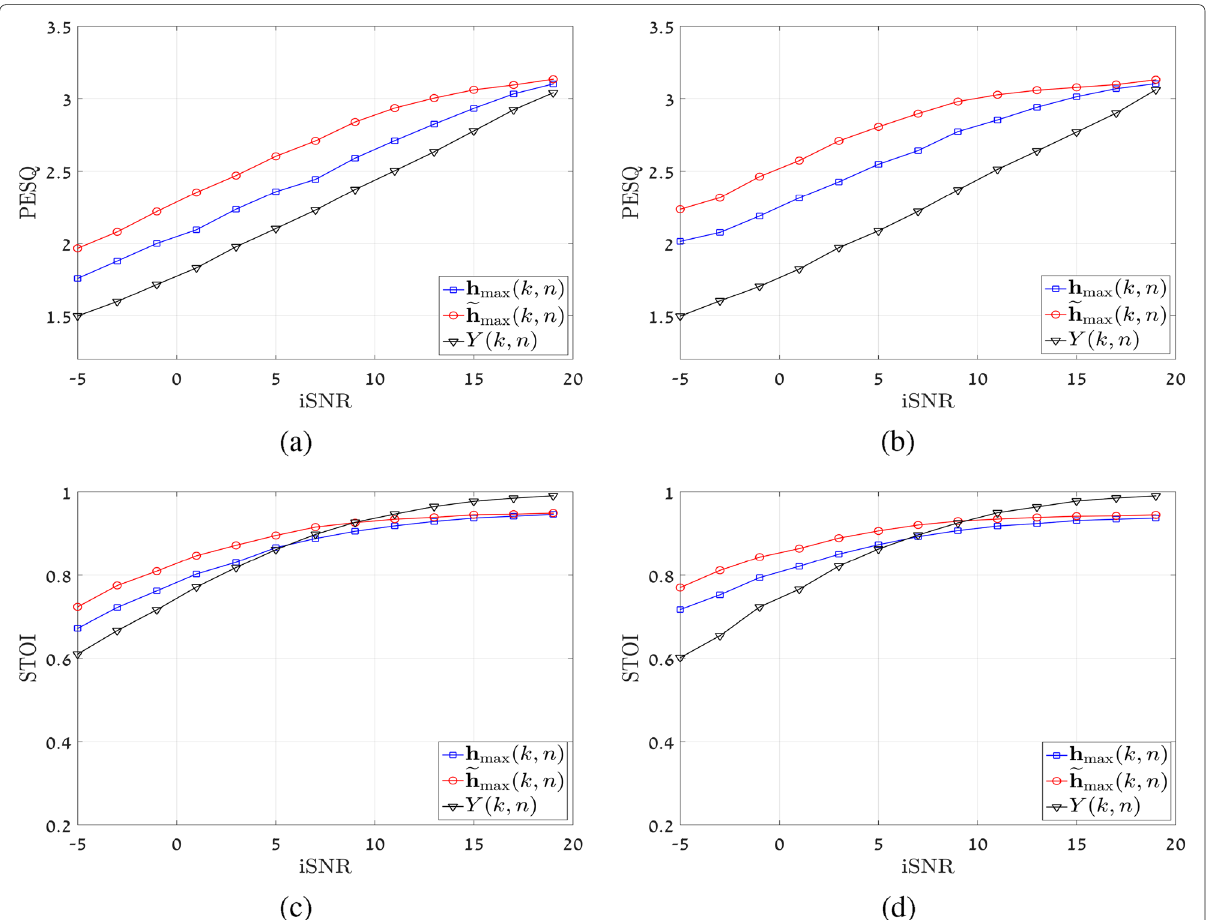
Fig. 3 PESQ and STOI scores of TIMIT speech signals as a function of the iSNR for N = 3 and N = 7 in the presence of white Gaussian noise. a PESQ scores with N = 3. b PESQ scores with N = 7. c STOI scores with N = 3. d STOI scores with N = 7. We set τ y = 2 for the quadratic filter (cid:6) h max ( k , n